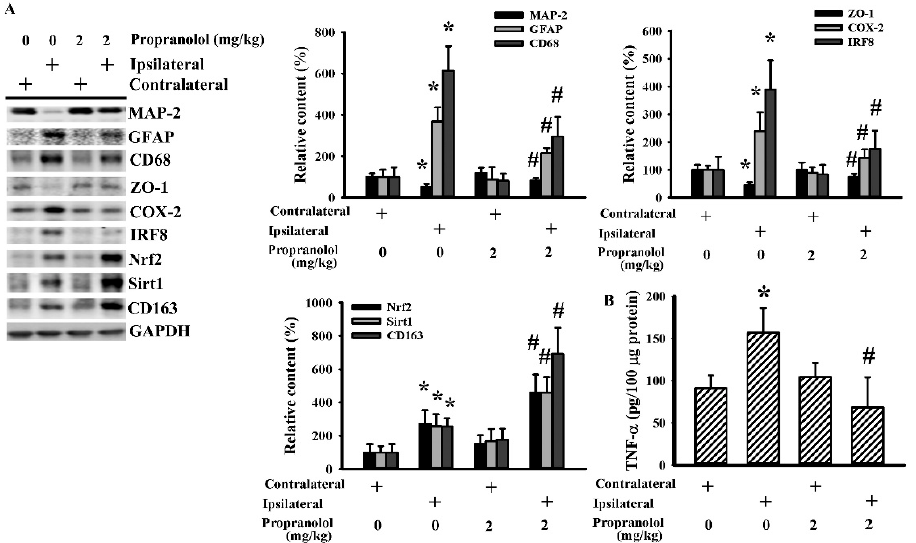
Figure 4. Propranolol alleviated postischemic brain inflammation. Rats receiving a normal saline vehicle or a propranolol (2 mg/kg) intraperitoneal injection were subjected to permanent cerebral ischemia for 24 h. Proteins were extracted from the contralateral and ipsilateral cortical tissues and subjected to Western blot ( A ) with the indicated antibodies or ELISA for the measurement of TNF- α ( B ). * p < 0.05 vs. the contralateral tissues of the vehicle group and # p < 0.05 vs. the ipsilateral tissues of the vehicle group, n = 6.